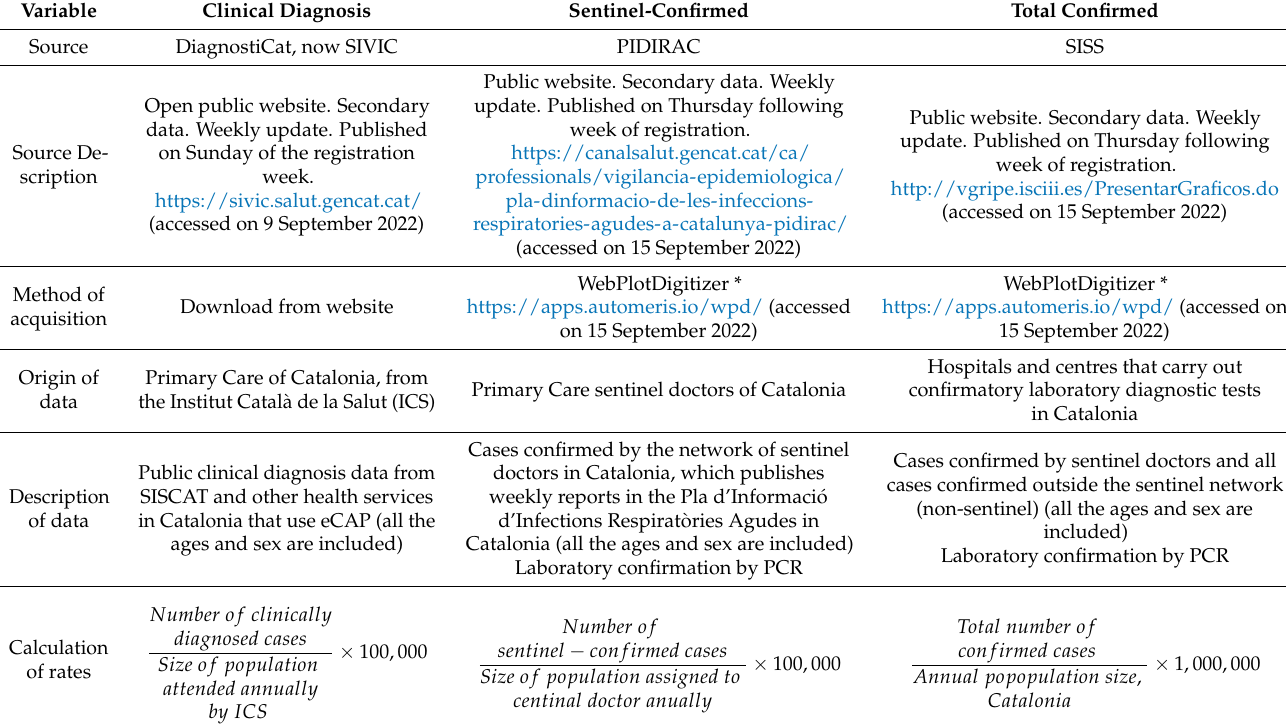
Table 1. Description of the data sources and